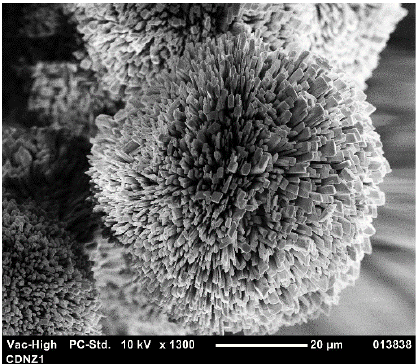
Figure 5. Scanning electron microscopy picture of ArgFum crystals obtained during PE standard